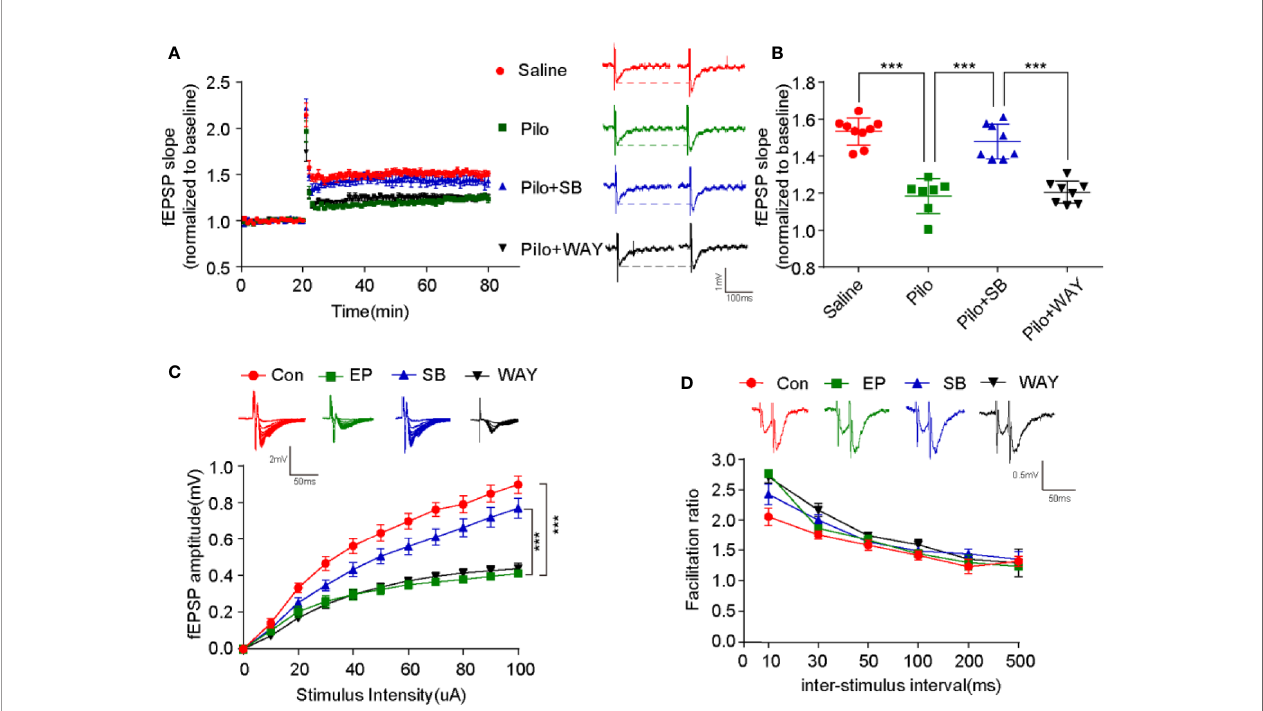
FIGURE 4 | SB271046 improved hippocampal synaptic function in chronic epileptic rats. (A) Successful recording of LTP via patch-clamp. (B) Analysis of fEPSP during the last 10 minutes among the four groups. The potentiation in the Pilo group decreased signi fi cantly compared with that in the Saline group. It was rescued by SB271046 but not by WAY181187. For comparing: ANOVA, F (3,28) = 40.063, p = 0.0000; for the Saline group (n=9 from 5 rats) vs. the Pilo group (n=7/4, 7 from 4 rats): p < 0.001; for the Pilo group vs. the Pilo+SB group (n=8/4), p < 0.001; for the Pilo+SB group vs. the Pilo+WAY group (n=8/4), p < 0.001. Signi fi cance was determined by one-way ANOVA with Bonferroni post hoc analysis (*** p < 0.001). (C) Input-output curve. The scatter plot was constructed by averaging three consecutive sweeps at a current interval of 10 m A. For comparing: ANOVA, F (3,346) = 50.277, p < 0.001; for the Saline group vs. the Pilo group: p < 0.001; for the Pilo group vs. the Pilo+SB group, p < 0.001; for the Pilo+SB group vs. the Pilo+WAY group, p < 0.001. Signi fi cance was determined using a two-factor mixed ANOVA with Bonferroni post hoc analysis. (*** p < 0.001). (D) Paired-pulse facilitation ratios. No differences were observed among the four groups. F (3,128) = 1.361, p = 0.2576. Statistical comparisons were analyzed by two-factor mixed ANOVA with Bonferroni post hoc